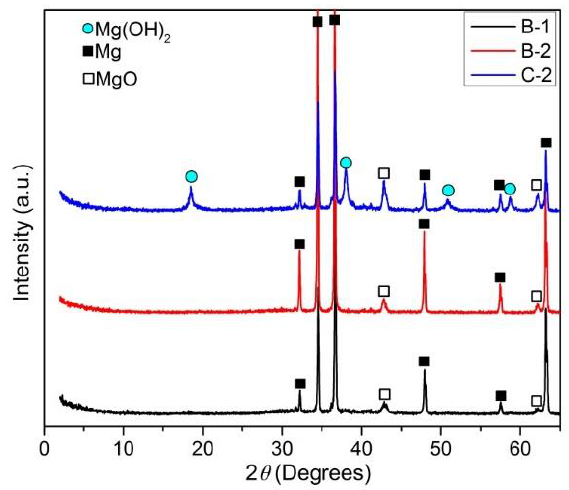
Figure 7. XRD patterns of immersed samples B-1, B-2, and C-2.